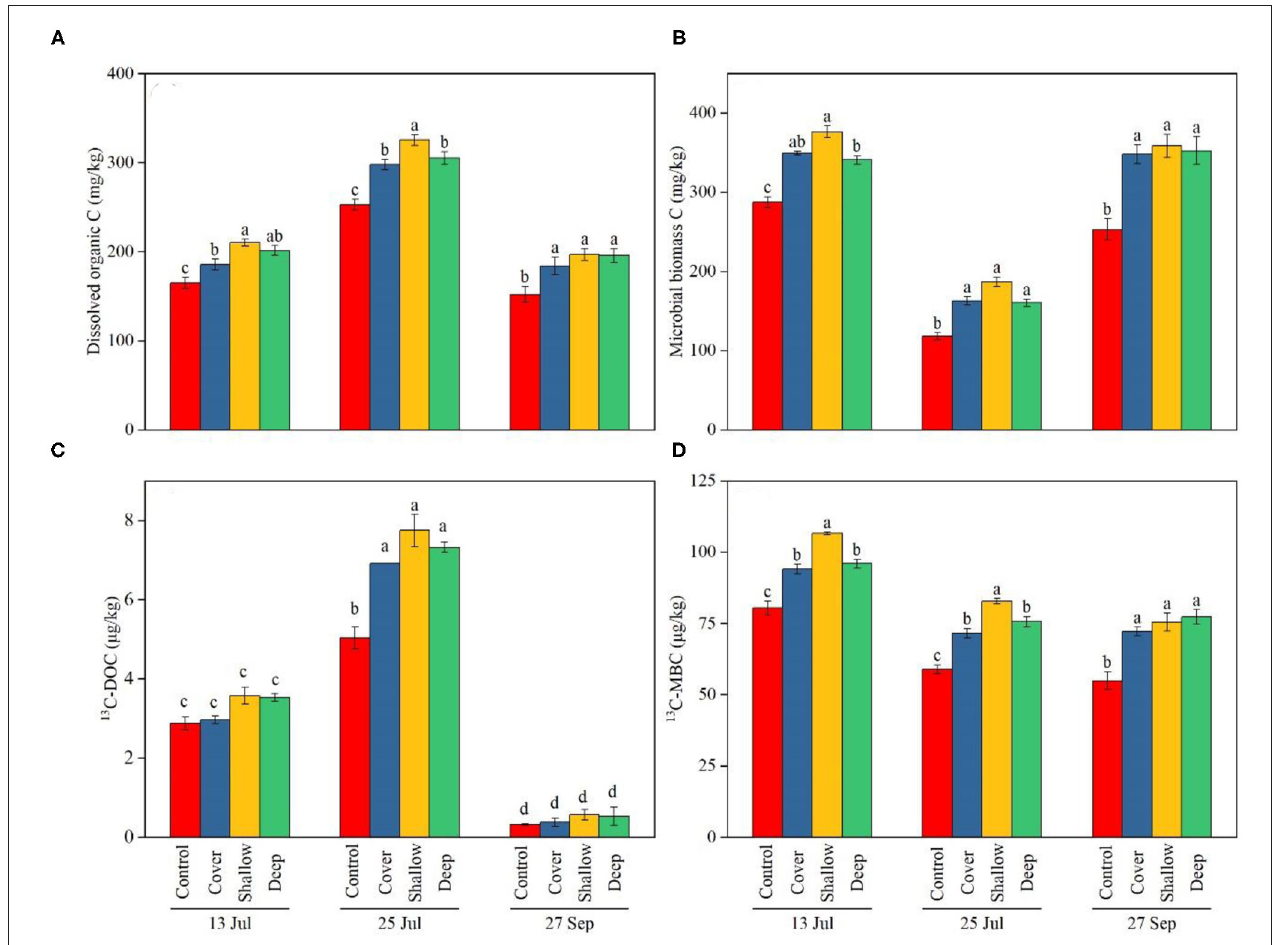
FIGURE 4 | Dissolved organic carbon (DOC) (A) , microbial biomass carbon (MBC) (B) , 13 C in DOC (C) , and 13 C in MBC (D) in 0–40cm soil layer on the three sampling dates [13 Jul: early jointing, 62 days after sowing (DAS); 25 Jul: late jointing, 74 DAS; 27 Sep: grain maturity, 138 DAS]. Means ± SE ( n = 3). Depending on significance of the interaction, different letters denote significant differences among treatments on a specific sampling date (A,B,D) or among sampling dates × treatments (C) ( P < 0.05). Control, no straw added; Cover, straw added to the soil surface; Shallow, straw incorporated at the 0–20cm soil depth; Deep, straw incorporated at the 20–40cm soil